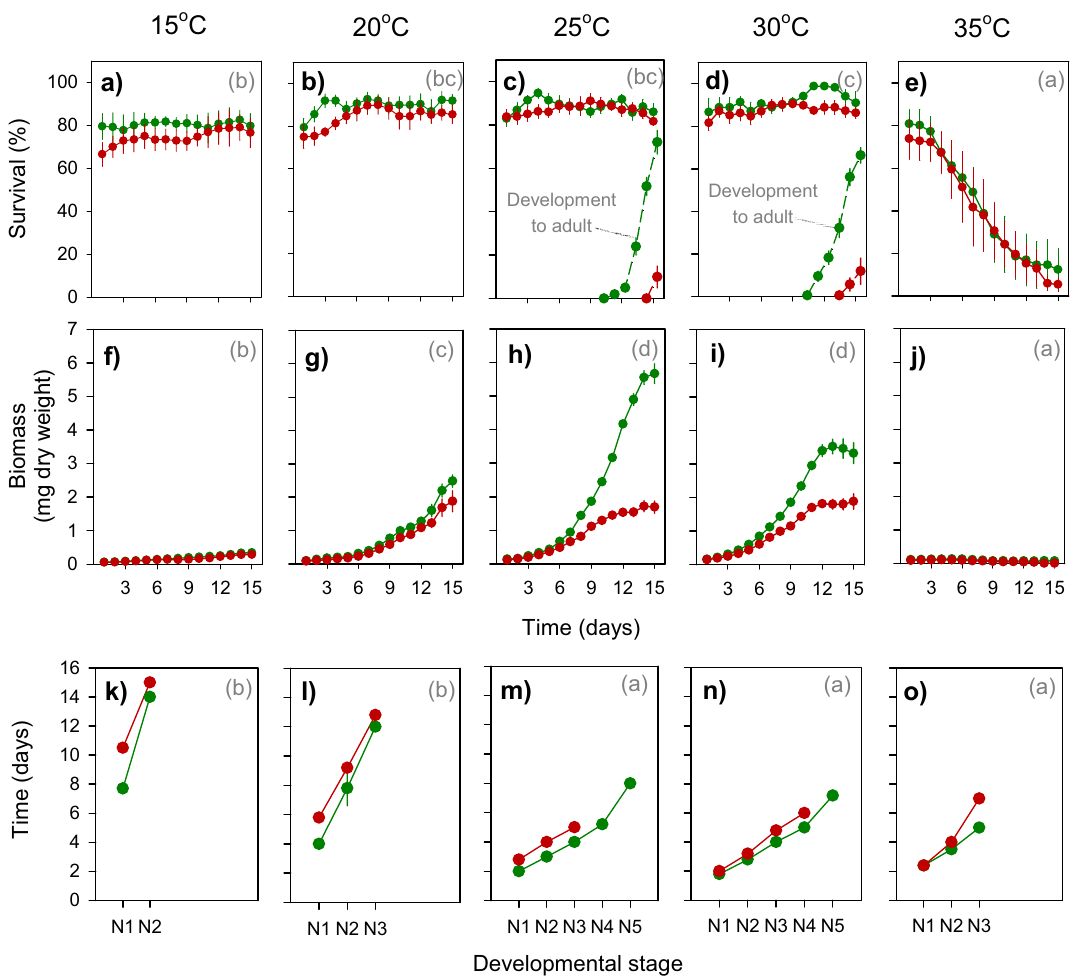
Figure 3. Daily survival and biomass of Nilaparvata lugens nymphs on susceptible (IR22: green circles) and resistant (IR62: red circles) rice varieties, with associated nymphs development stages. Plants were grown at 15 °C ( a,f,k ), 20 °C ( b,g,l ), 25 °C ( c,h,m ), 30 °C ( d,i,n ) and 35 °C ( e,j,o ). Relative humidity was maintained at 80%. Results for nymph survival, including development to adults ( a-e ), nymph biomass ( f-j ), and nymph developmental stages ( k–o ) are indicated. N2 = second instar, N3 = third instar, etc., A = adult. Standard errors are included (N = 5). Lowercase letters indicate homogenous temperature groups (Tukey, P ≤